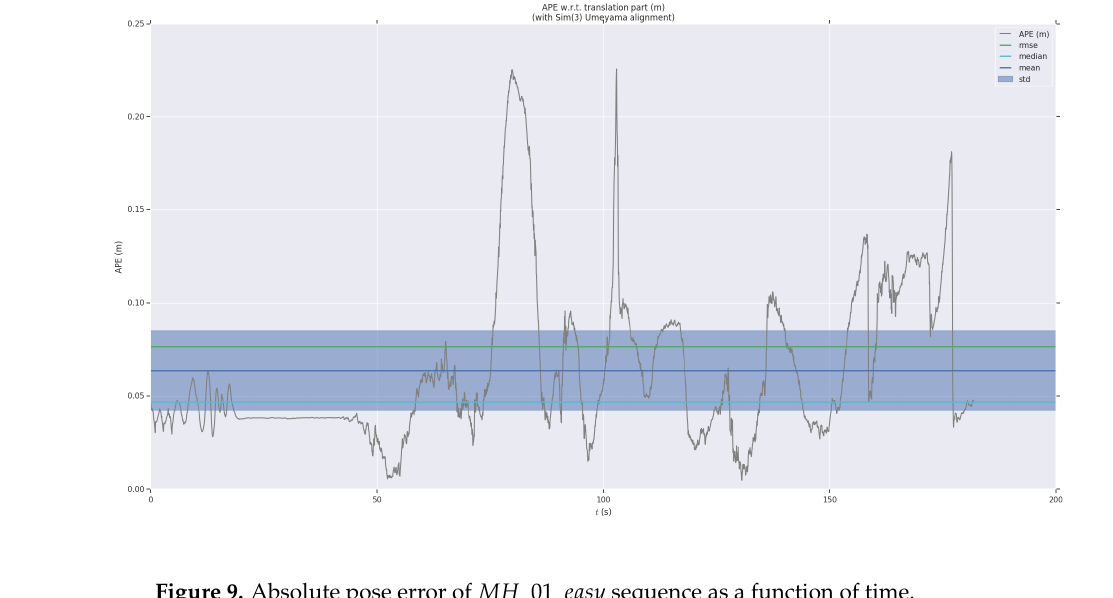
Figure 9. Absolute pose error of MH _01_ easy sequence as a function of time.